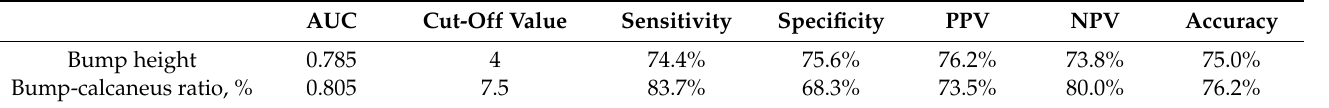
Table 3. The cut-off value and area under the curve (AUC) of bump height and bump calcaneus ratio. AUC